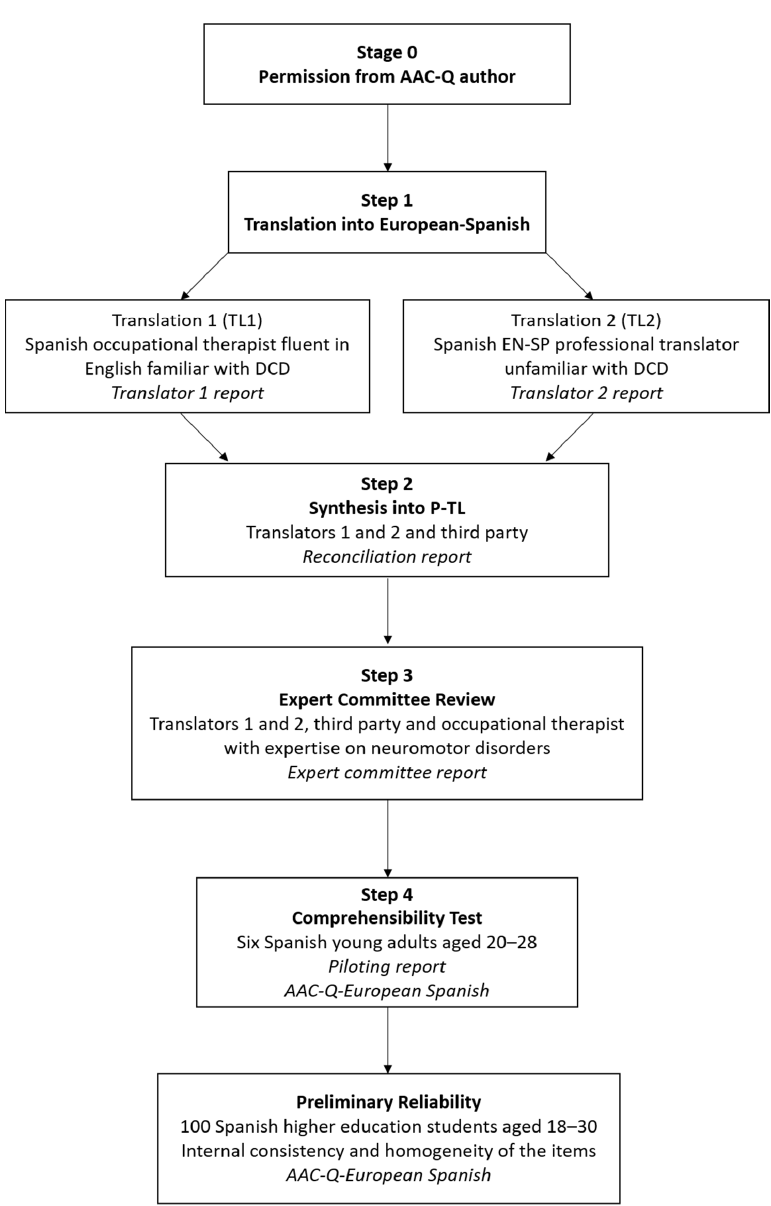
Figure 1. Cross-cultural adaptation process of the European Spanish